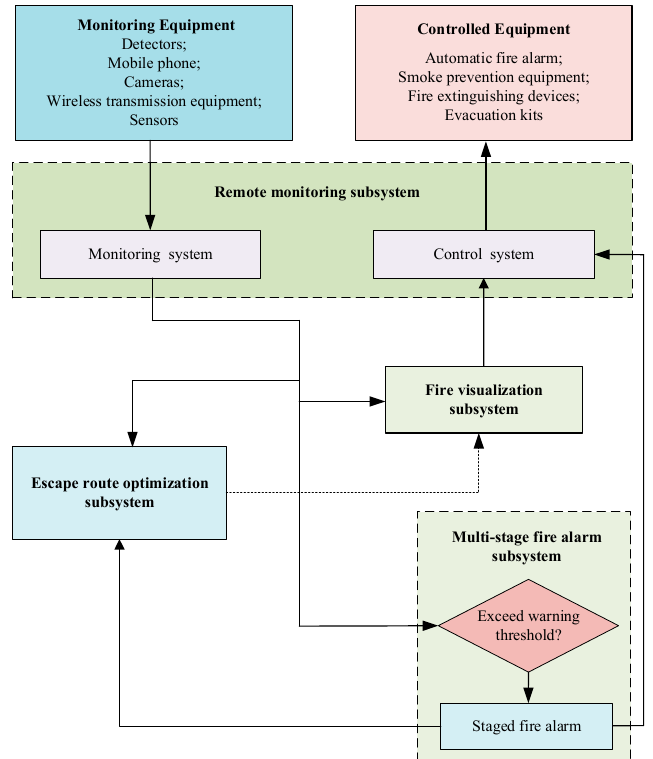
Figure 2. Operation process of the BIM-based fire safety management system.